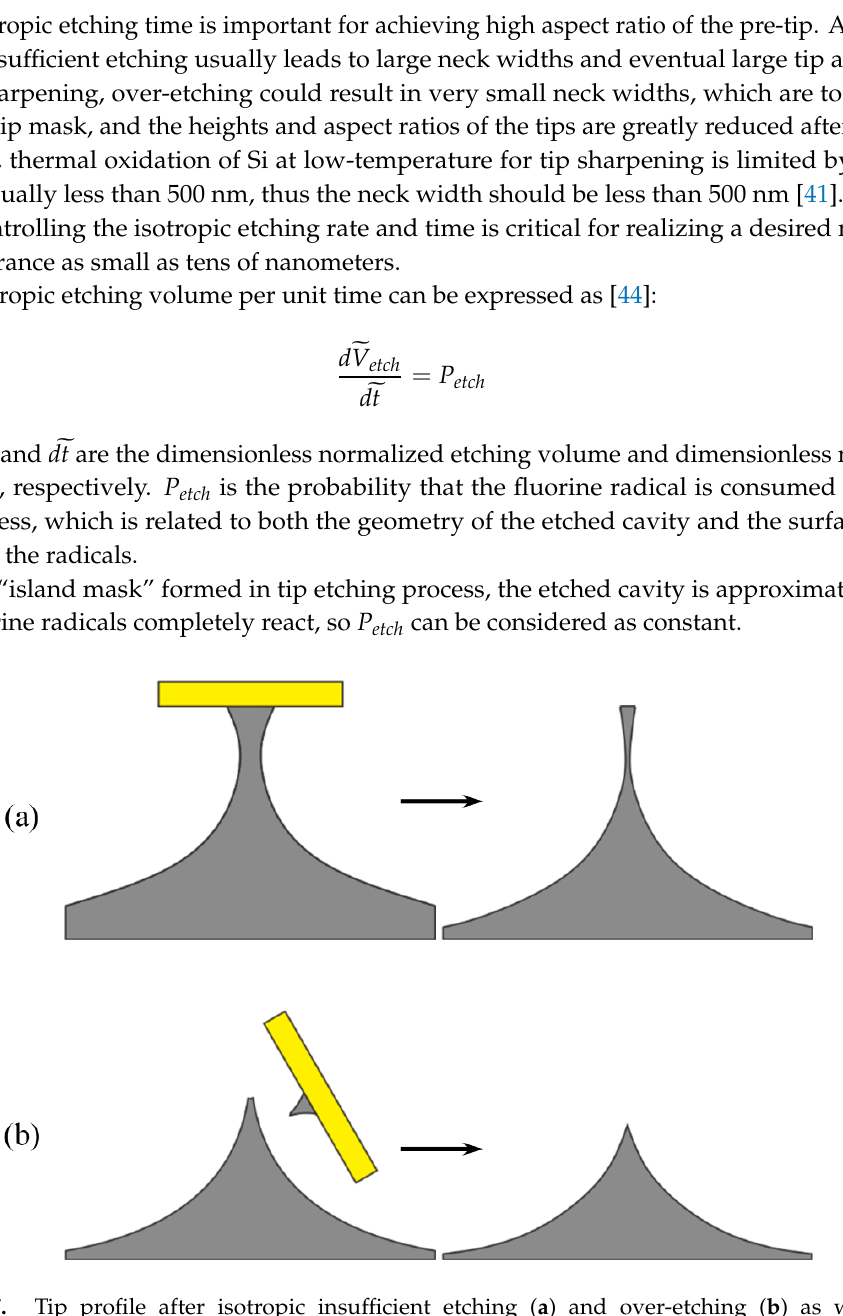
Figure 7. Tip profile after isotropic insufficient etching ( a ) and over-etching ( b ) as well as thermal oxidation.